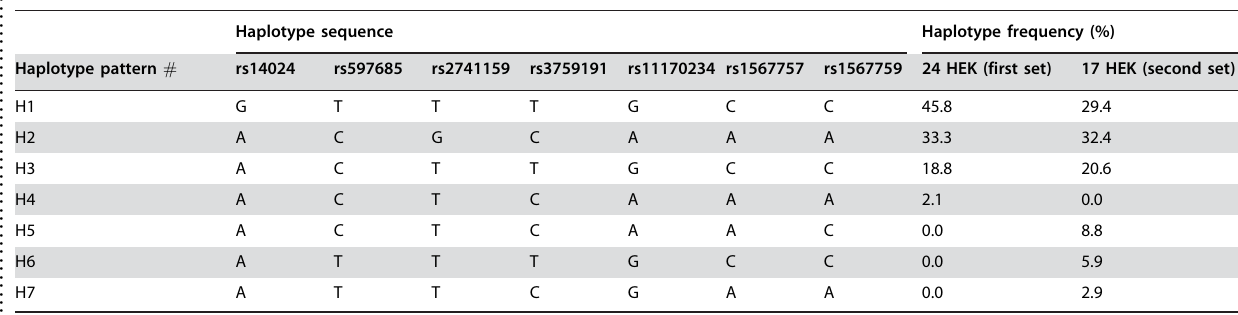
Table 1. KRT1 haplotype patterns in HEK cells. .. ... .... ... ... .... ... ... .... ... ... .... ... ... .... ... ... .... ... ... .... ... ... .... ... ... .... ... ... .... ... ... .... ... ... .... ... ... .... ... ... .... ... ... .